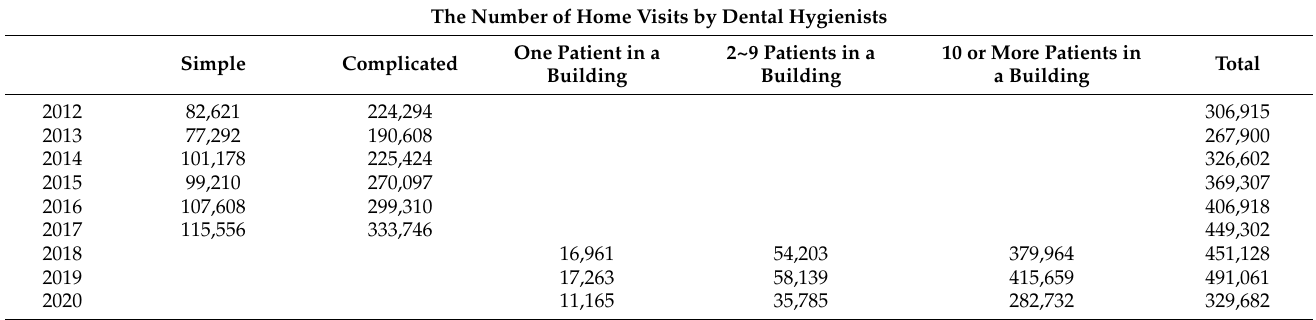
Table 9. The number of home visits by dental hygienists.